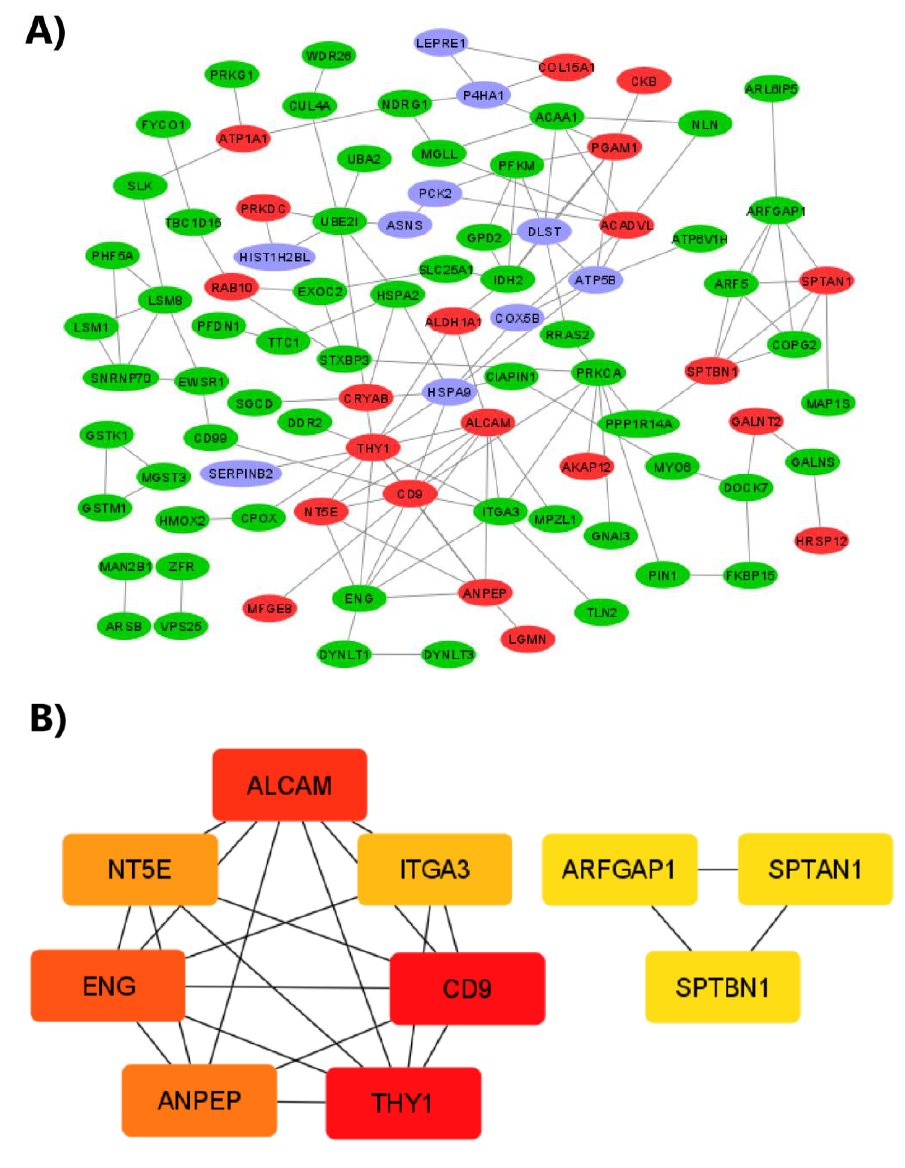
Figure 6. Protein–protein interaction regulatory network. ( A ) DEPs and proteins identified exclu- sively in the IPF-1 and IPF-2 groups were combined to construct a regulatory network using STRING software to visualize the interaction with evidence such as network edge importance. The active interaction sources were Text Extraction, Experiments, Database, Co-expression, Neighborhood, Gene Fusion, and Co-occurrence, with a required minimum interaction score of medium confidence (0.4). The red color represents up-regulated proteins, the blue color represents down-regulated proteins, and the green color represents proteins identified exclusively in the IPF-1 and IPF-2 groups. ( B ) The top 10 proteins with the highest degree of PPI network connectivity were identified by the MMC method using CytoHubba.